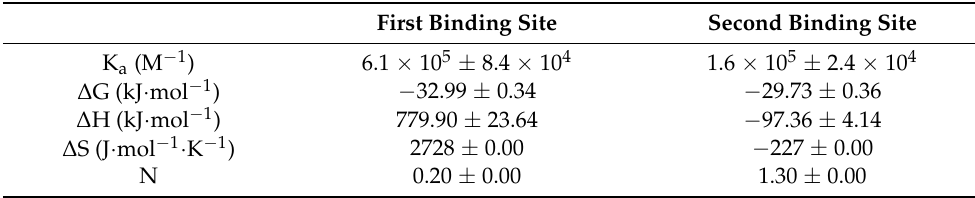
Table 1. The calculated binding constants (K a ), the Gibbs energy ( ∆ G), the enthalpy ( ∆ H), and entropy changes ( ∆ S) with the stoichiometry (N) of the binding between BSA and B 1 -Au NCs based on the ITC